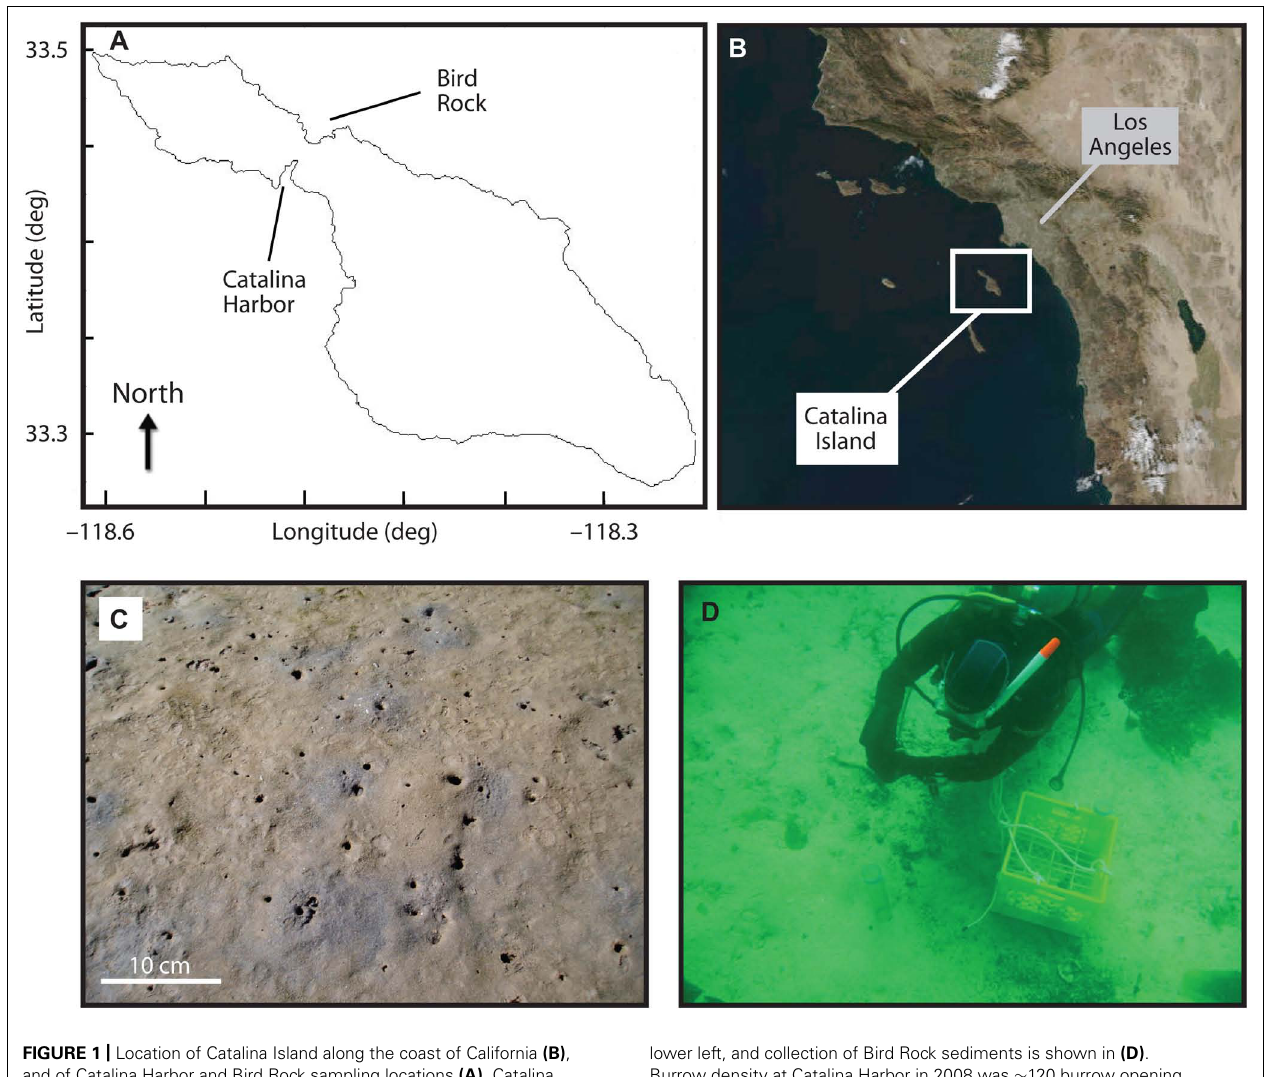
lower left, and collection of Bird Rock sediments is shown in (D) . Burrow density at Catalina Harbor in 2008 was ∼ 120 burrow opening per square